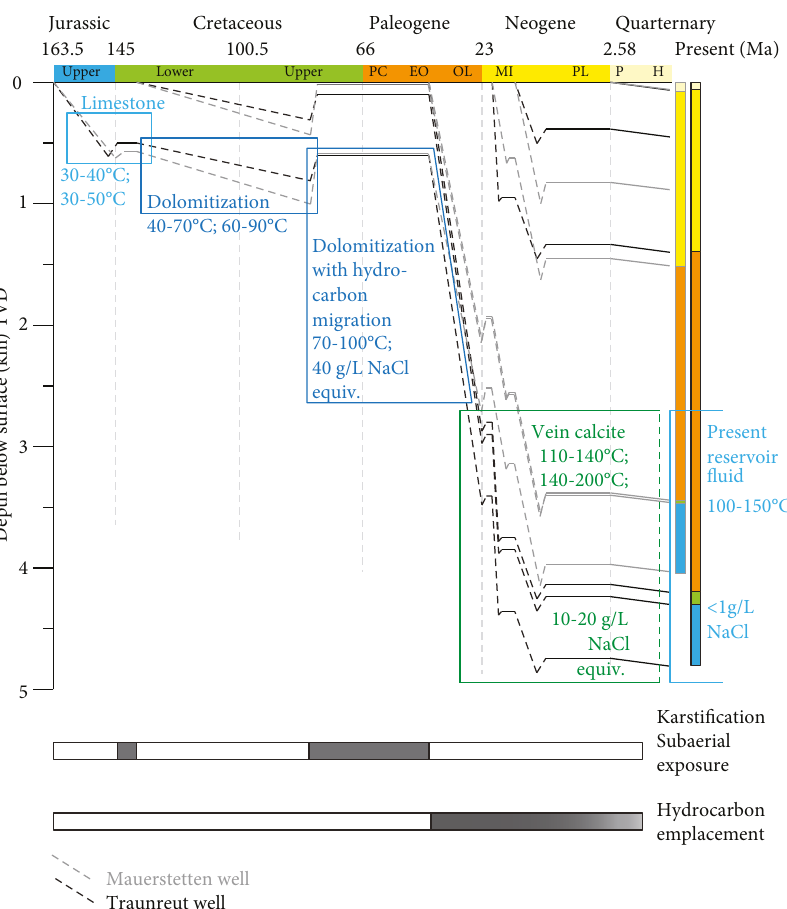
Figure 14: Subsidence plot for the Upper Jurassic carbonate rocks, divided into the western (gray) and eastern (black) Molasse Basin. The eastern Molasse Basin was down-lifted further than the western Molasse Basin, and both parts have reached the maximum depth today. The sediment thickness was used from the borehole data at Traunreut (eastern Molasse Basin) and Mauerstetten (western Molasse Basin) and was not corrected for compaction. Due to varying geothermal gradients, the relative depths were